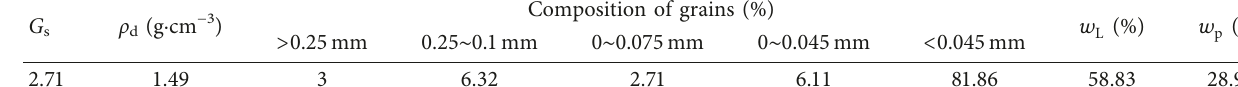
Table 1: The basic physical properties of the clay specimens.